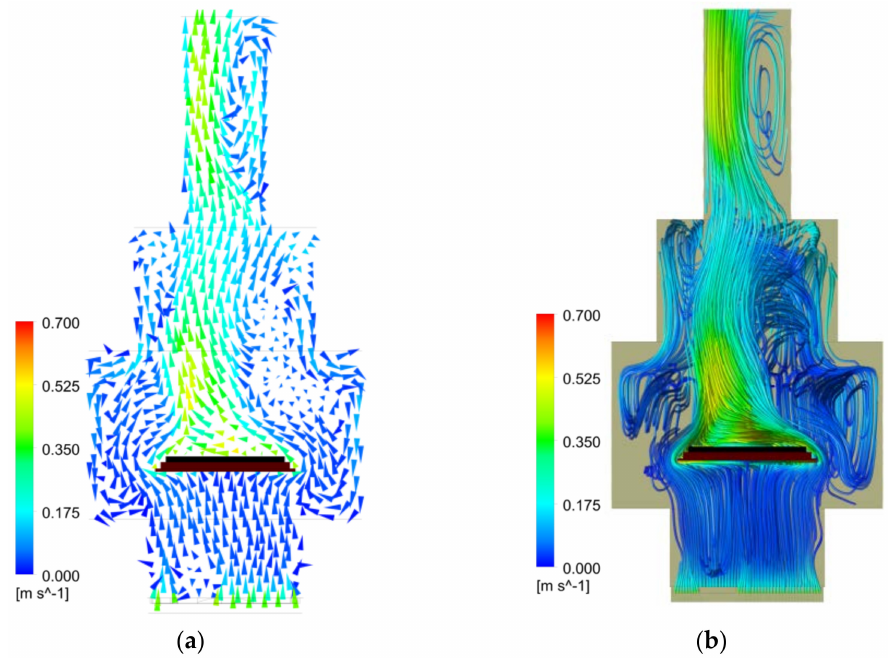
Figure 6. The velocity field, in the form of ( a ) vectors and ( b ) streamlines in the reactor cross-section, obtained at the pressure of 2.5 bar.